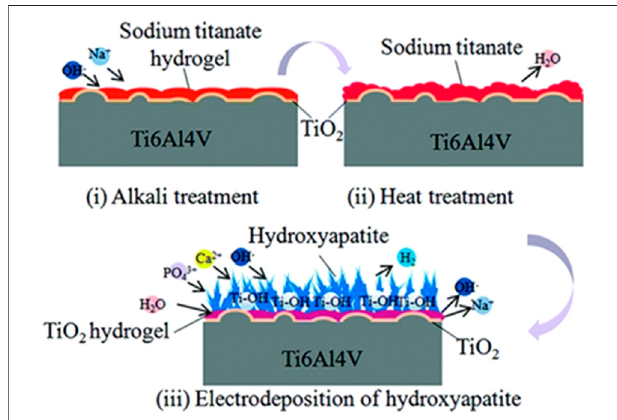
FIGURE 8 | Formation of titanium alloy coating through alkali – heat treatment and HA-electrodeposited surface treatment. Image reproduced from Song et al.